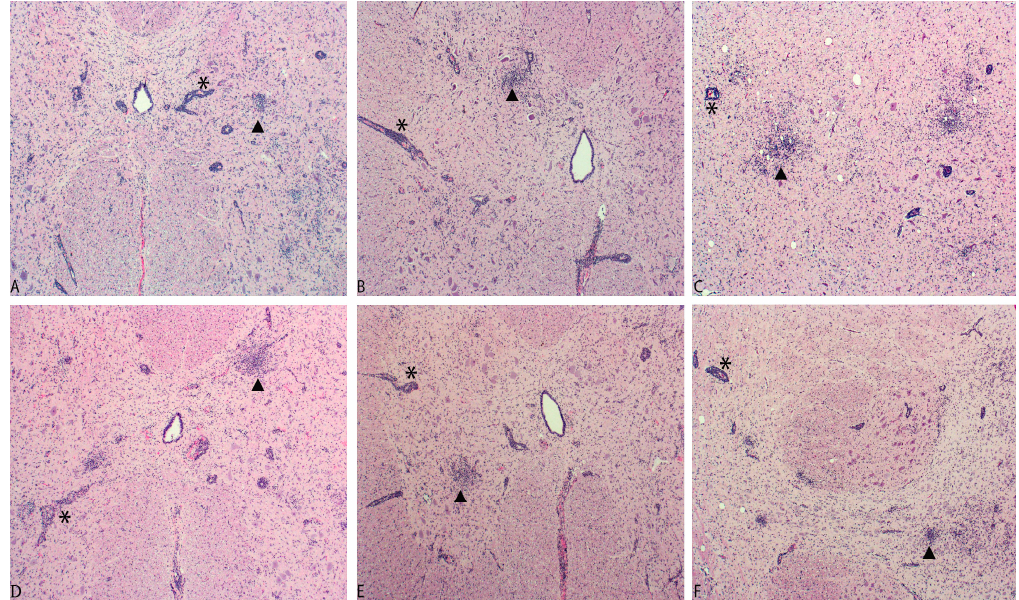
Figure 2. Pig No. 74, inoculated with PTV-2, day post-inoculation 11 (DPI 11). Lymphoplasmacytic myelitis with expansion of the Virchow – Robin spaces (*) and multifocal areas of gliosis ( ▲ ) in cervical spinal cord ( A ), lumbar spinal cord ( B ), and midbrain ( C ); Pig No. 77 inoculated with PTV-11, day post-inoculation 11 (DPI 11) Lymphoplasmacytic myelitis with expansion of the Virchow – Robin spaces (*) and multifocal areas of gliosis ( ▲ ) in cervical spinal cord ( D ), lumbar spinal cord ( E ), and midbrain ( F ). Table 5. Histopathologic severity score and distribution of lesions.